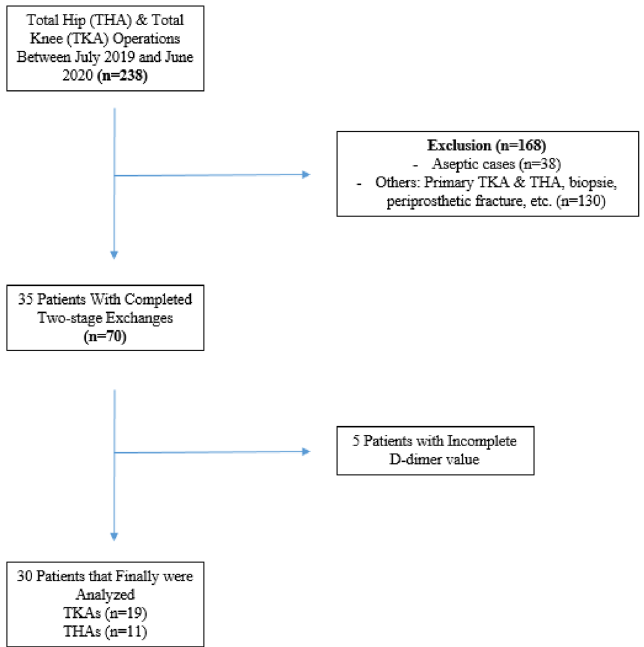
Figure 1. STROBE (Strengthening the reporting of observational studies in epidemiology) diagram of patients shows the study